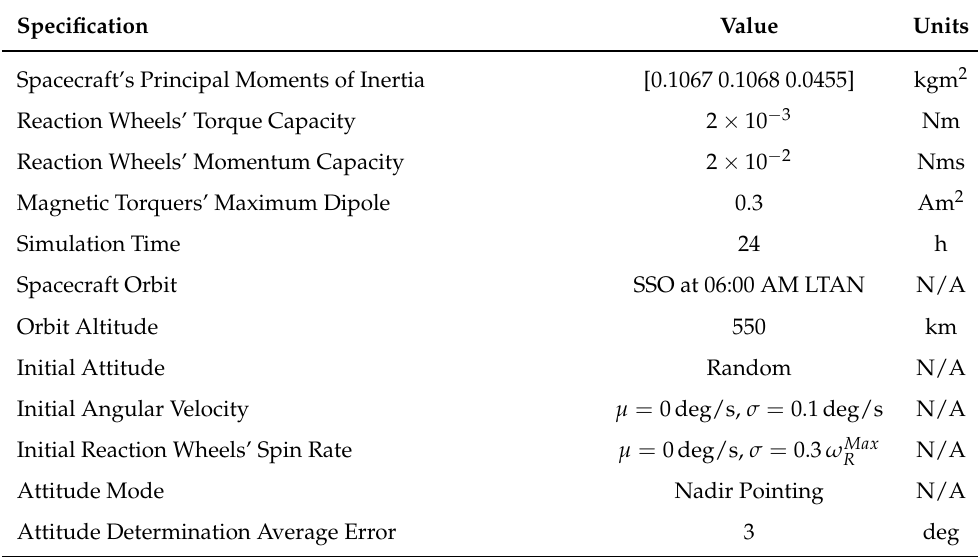
Table 1. Model-in-the-loop verification parameters.